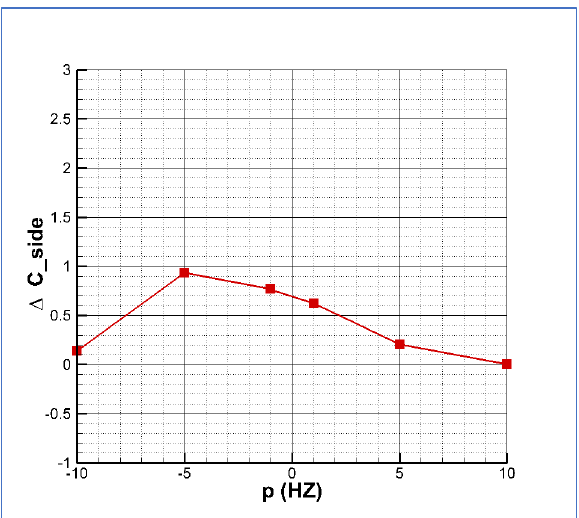
Figure 14. Separation of the side force coefficient from a linear law with symmetry flow condition at zero spin. Ma = 0.2, Re =2 × 10 6 and α = 45 deg. The separation is larger at the negative roll rates than at the positive roll rates. Addi- tionally, both values of this separation are positive. Therefore, there is a positive bias that indicates that rolling at lower velocities, approaching the limit of zero spin — either with negative spin or with positive spin — leads to a side force coefficient value of 0.70 approx- imately. This a quantification of the effect of this bias.